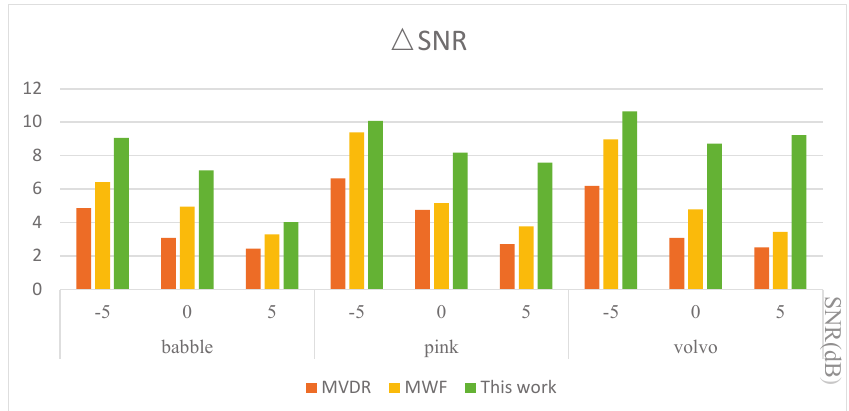
Figure 16. The comparison results of the improved SNR in different SNRs under different daily noise